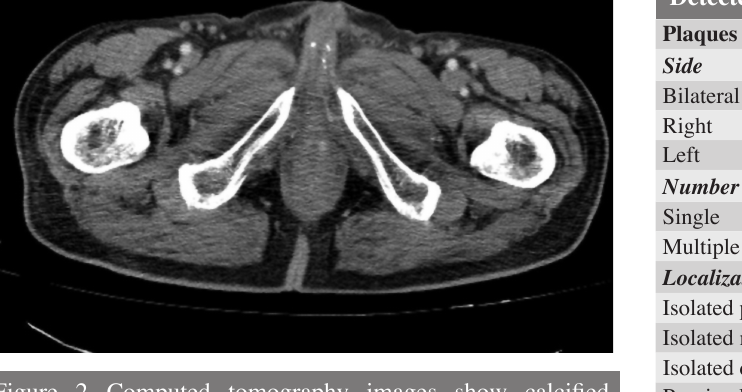
Figure 2. Computed tomography images show calcified Peyronie's plaques on both sides of the penis, multiple on the left-sided.